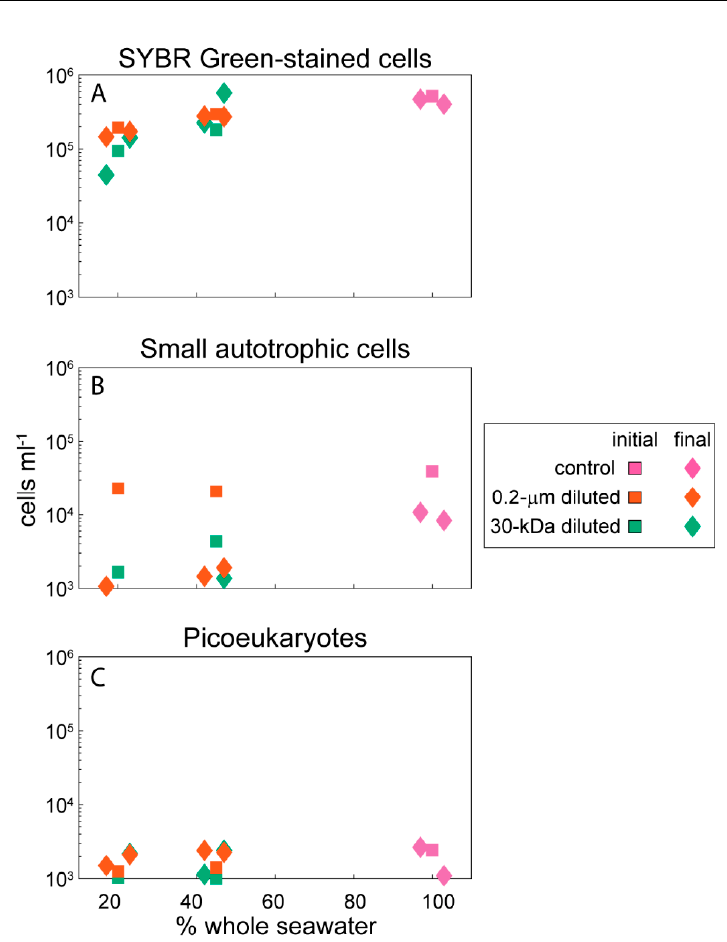
Figure 1. Abundance of microbial-sized cells at the initial and final points in the experiment. ( A ) SYBR Green-stained cells are heterotrophic cells counted with flow cytometry, ( B ) small autotrophic cells are the autofluorescing cells within the flow cytometry data, and ( C ) picoeukaryotes were counted with epifluorescence microscopy. The abundances have been jittered on the x -axis to improve clarity of the data presentation. The total abundance of microbial-sized cells was defined as the sum of all three datasets and was used to normalize the metabolite concentrations to cell-specific values for each organic compound. Data are plotted on a log scale to allow comparisons across the different groups. Table 1. Experimental design and concentrations of total organic carbon (TOC) in each treatment at the initial and final time points. The control is 100% whole seawater, while the 0.2-µm and 30-kDa treatments were diluted with water passed through 0.2-µm and 30-kDa filters, respectively. The table provides the amount each treatment was diluted. * The initial TOC sample for the 0.2-µm treatment with 20% whole seawater was lost.